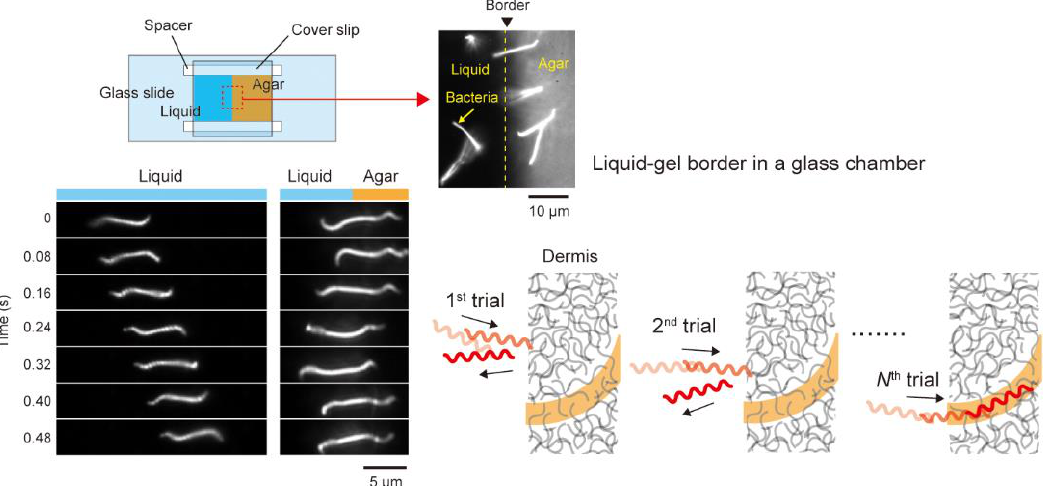
Figure 3. Swimming reversal enhanced in the liquid–gel border. The schematic (right bottom) explains a hypothetical scenario that the “trial-and-error”-like behavior allows the bacteria to find a path for easier invasion. This figure was made based on [20] with